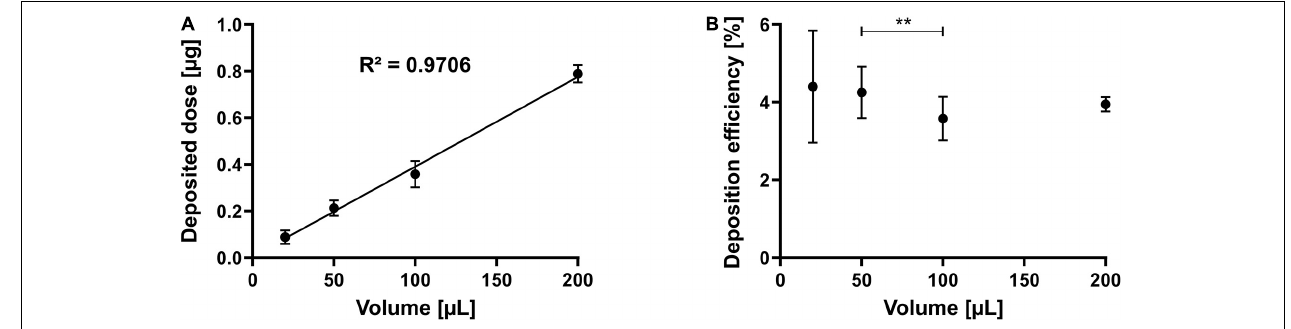
FIGURE 3 | Linearity by dose and efficiency. Sodium fluorescein solution is nebulized as described in the section “Materials and Methods.” (A) Deposited dose of a 100 µ g/ml solution at different invested volumes. (B) Deposition efficiency at different invested volumes. Error bars indicate standard deviation. N = 18 of six experiments (for 20 and 200 µ l) and N = 21 of seven experiments (for 50 and 100 µ l). One-way ANOVA, Tukey’s multiple comparisons test; ** p = 0.002.